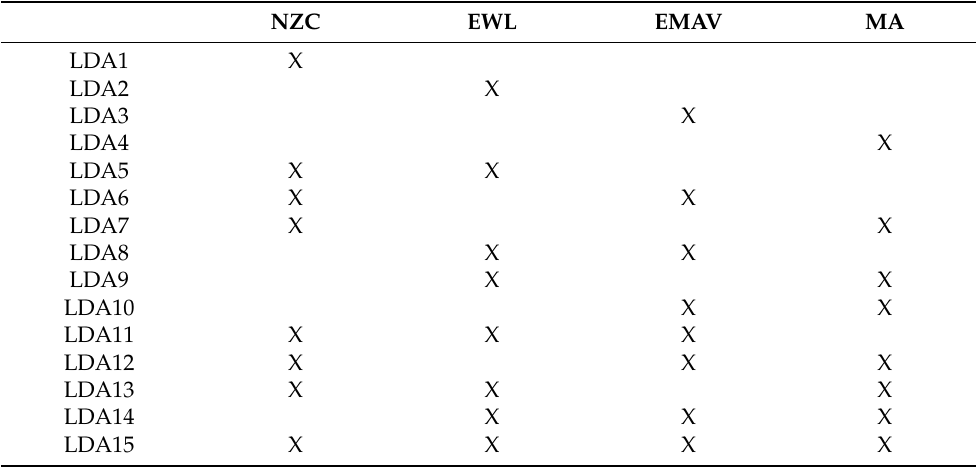
Table 1. All the different combinations of the EMG characteristics of all the performed LDAs.